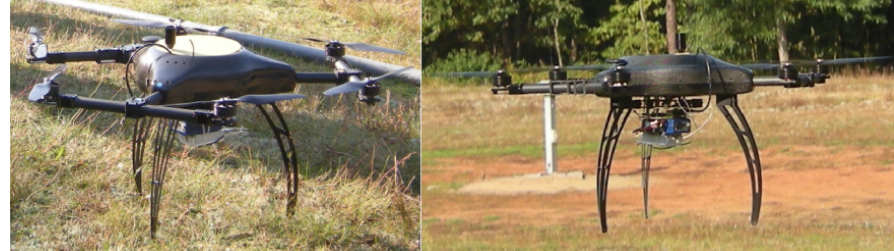
Figure 2. Versa X6 multicopter with scientific payload (AE-51 aethalometer and radiosonde